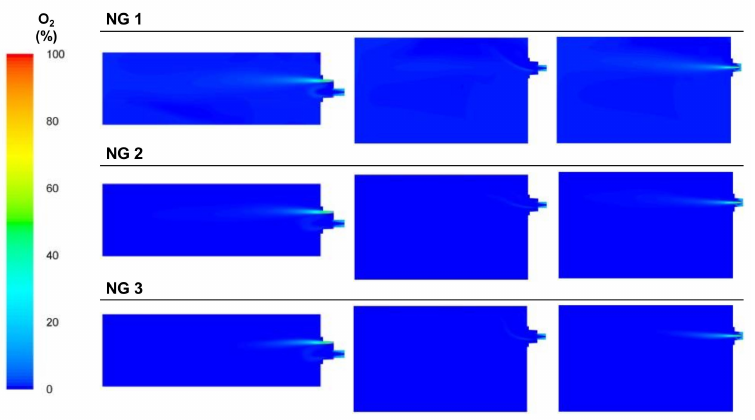
Figure 26. Contour plots of O 2 concentrations for the NG cases in the XZ1, XY1, and XY2 planes.